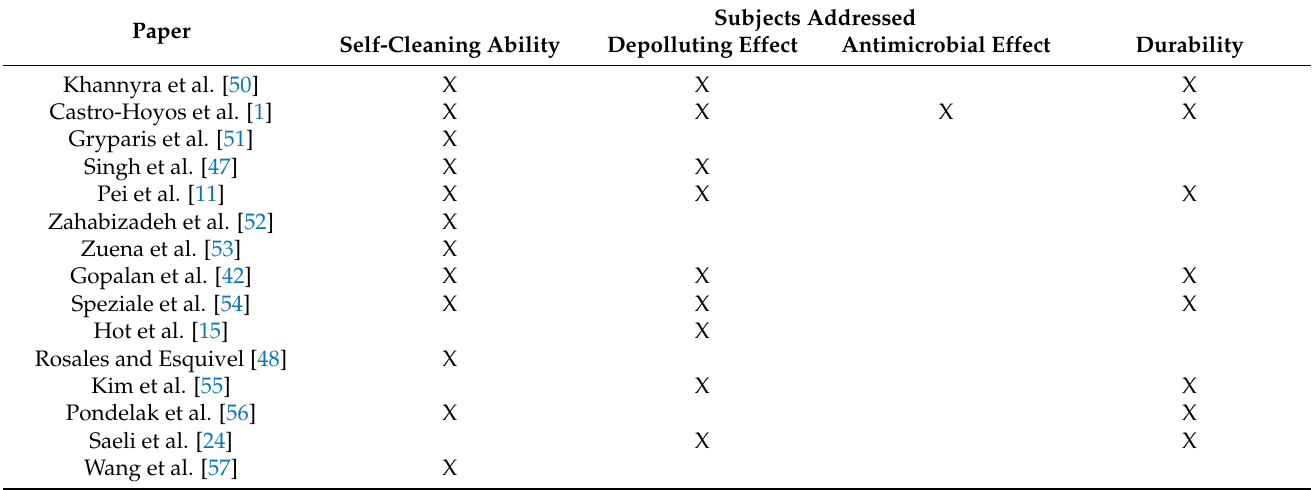
Table 1. Subjects addressed by the studied papers: self-cleaning ability, depollution effect, antimi- crobial effect, and durability.